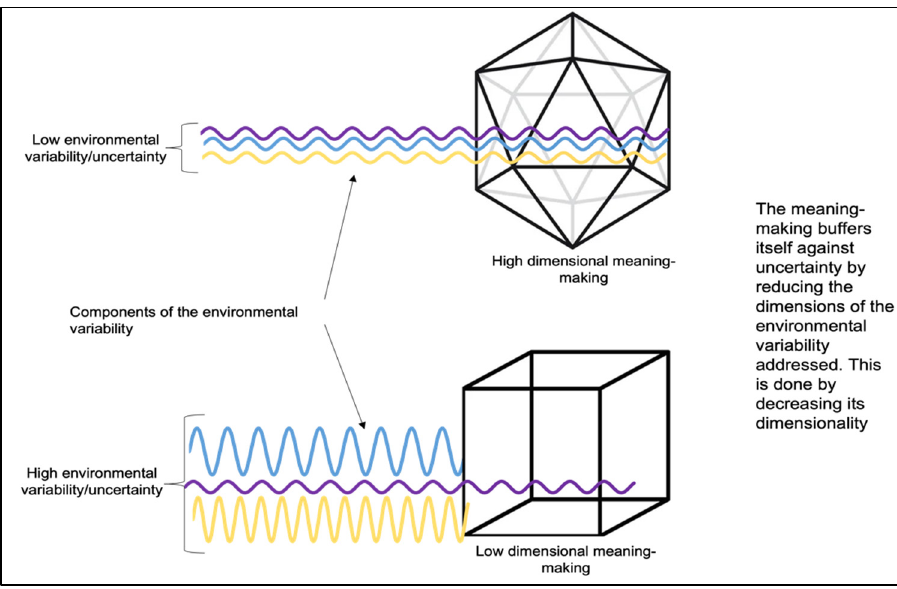
Figure 1. The regulation of uncertainty process of the SDM.